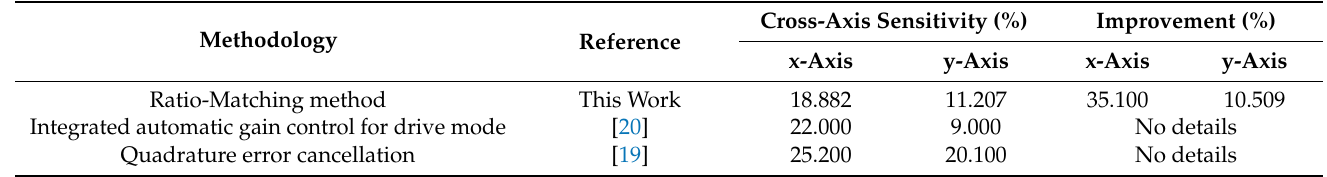
Table 3. Experimental Results Comparison of Fabricated Design with Reported Gyroscope.